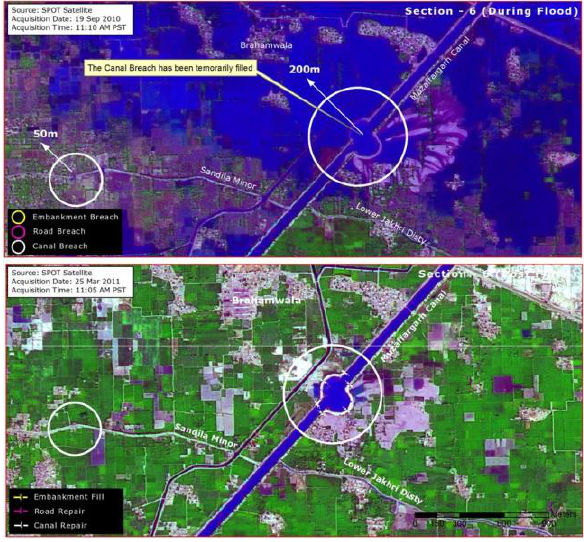
Figure 7. Filling of Muzaffargarh Canal Breach, Punjab